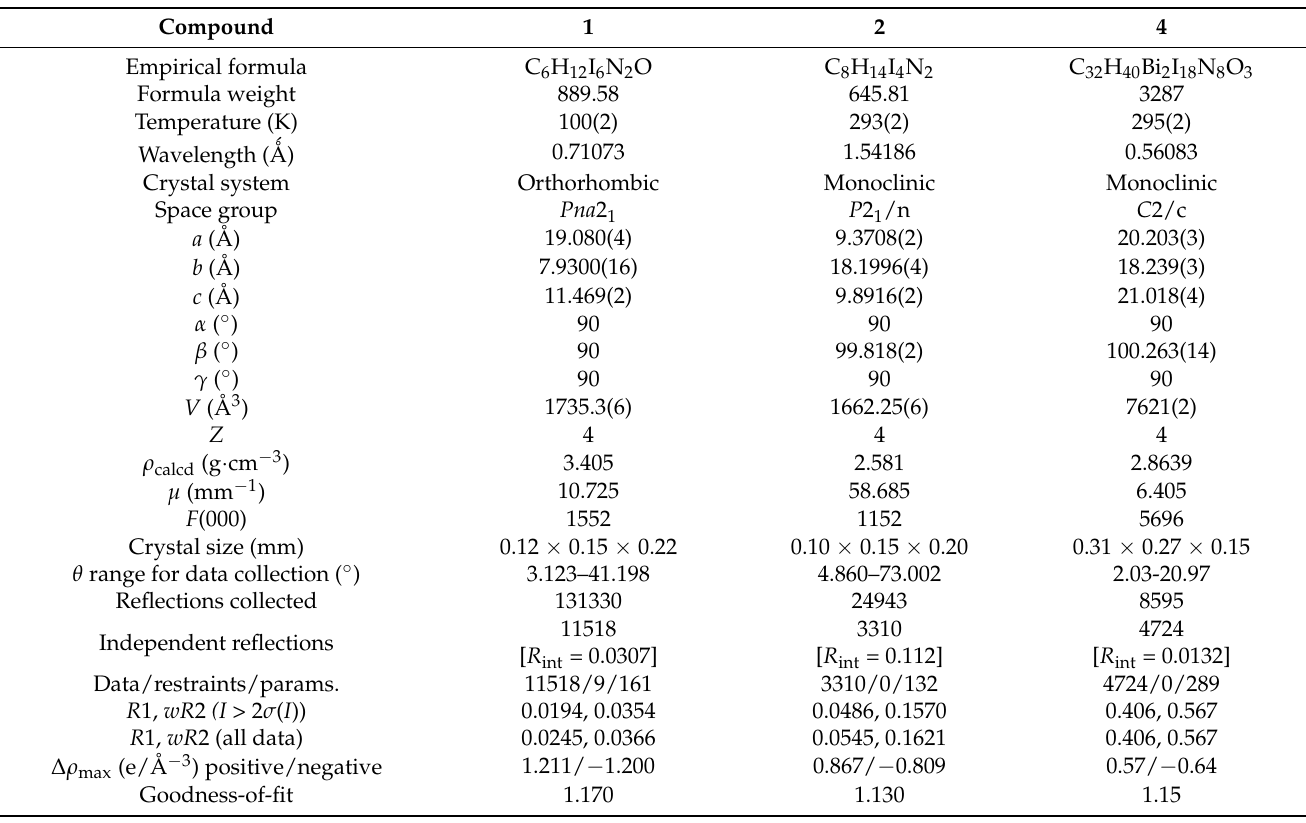
Table 3. Crystallographic data for 1 , 2 , and 4